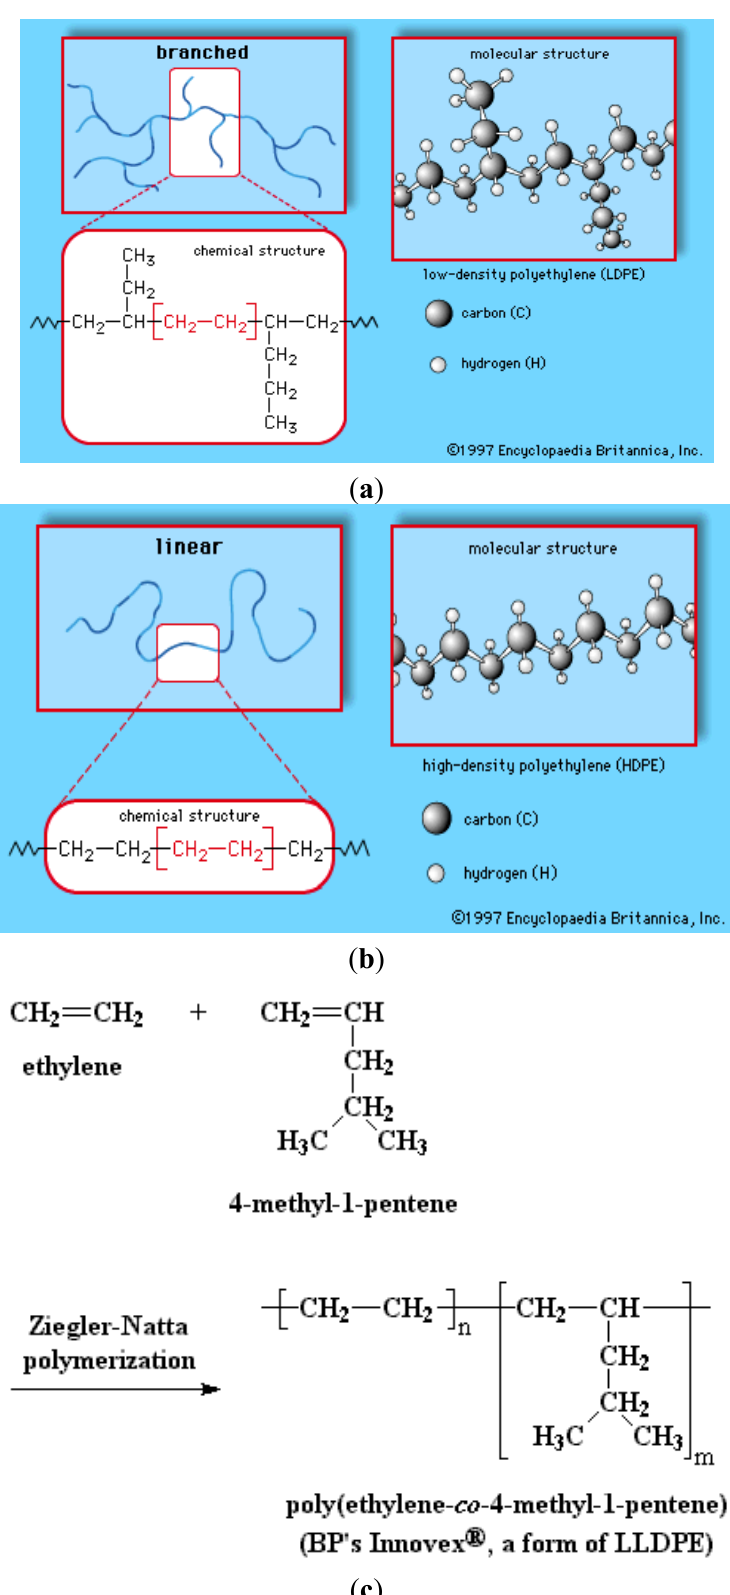
Figure 5. General representations of various polyethylene variants. ( a ) LDPE; ( b ) HDPE; and ( c ) LLDPE. Obtained with permission from MAG Recycling Services Pty Ltd. [30] and the University of Southern Mississippi